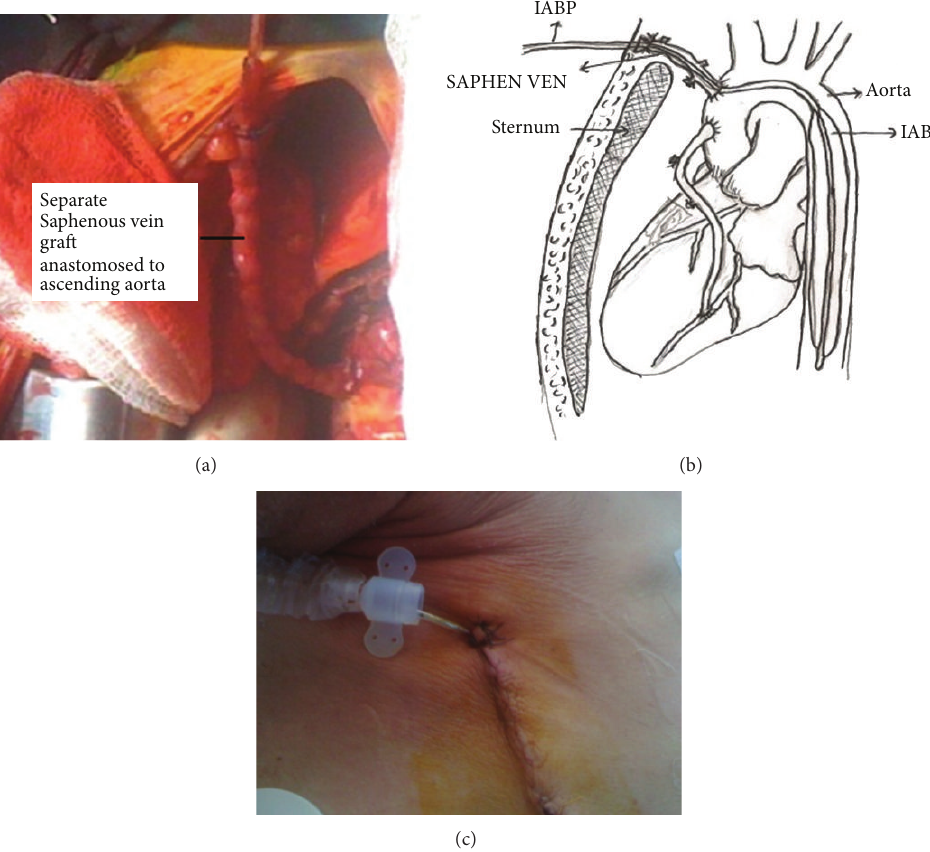
Figure 1: IABP catheter insertion through a separate saphenous vein graft anastomosed to the ascending aorta. (a) Intraoperative picture. (b) Schematic drawing of transaortic IABP procedure. SAPHEN VEN = saphenous vein graft. (c) Appearance of balloon catheter after skin